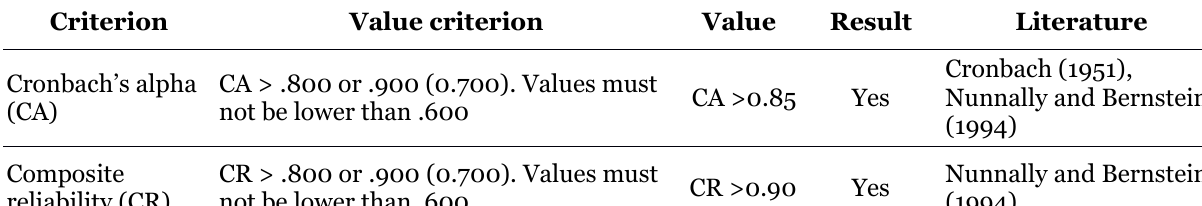
The Model Predictive Power Indicators and GoF Indices Goodness-of-Fit Measures for Measurement Model